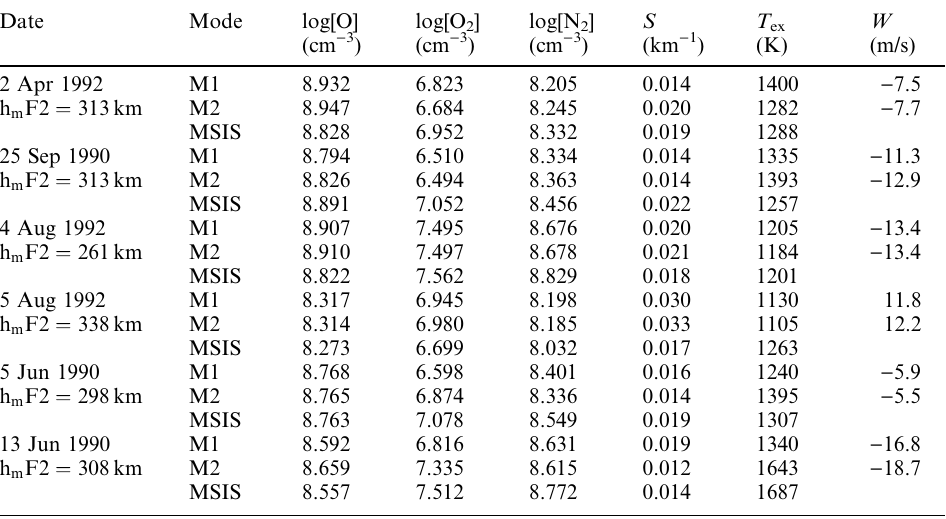
Table 3. Calculated thermospheric parameters and MSIS-83 model predictions at the height of h m